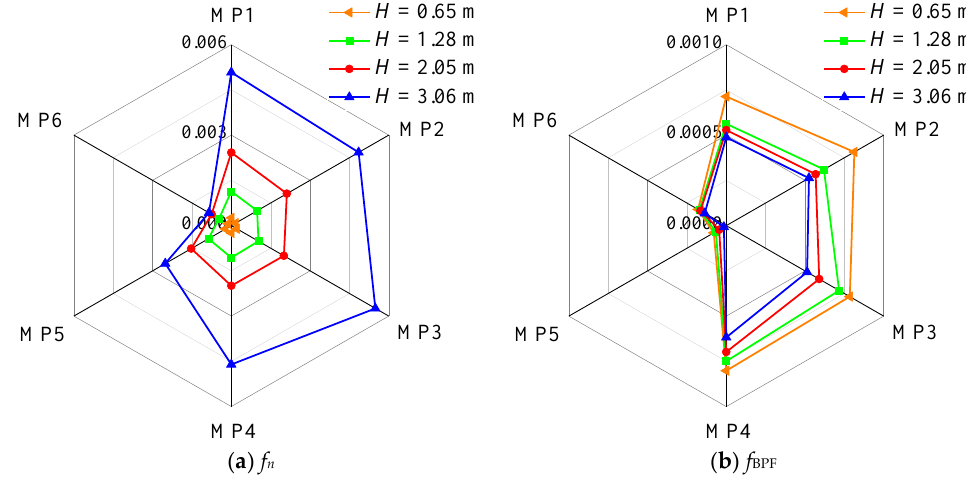
Figure 6. The C p vlaue of f n and f BPF among MP1–6 at α = +2° with different runaway heads. According to Ref. [33], the low-frequency component of the pressure pulsation ac- counts from the wake vortex, and the empirical formula is as follows: